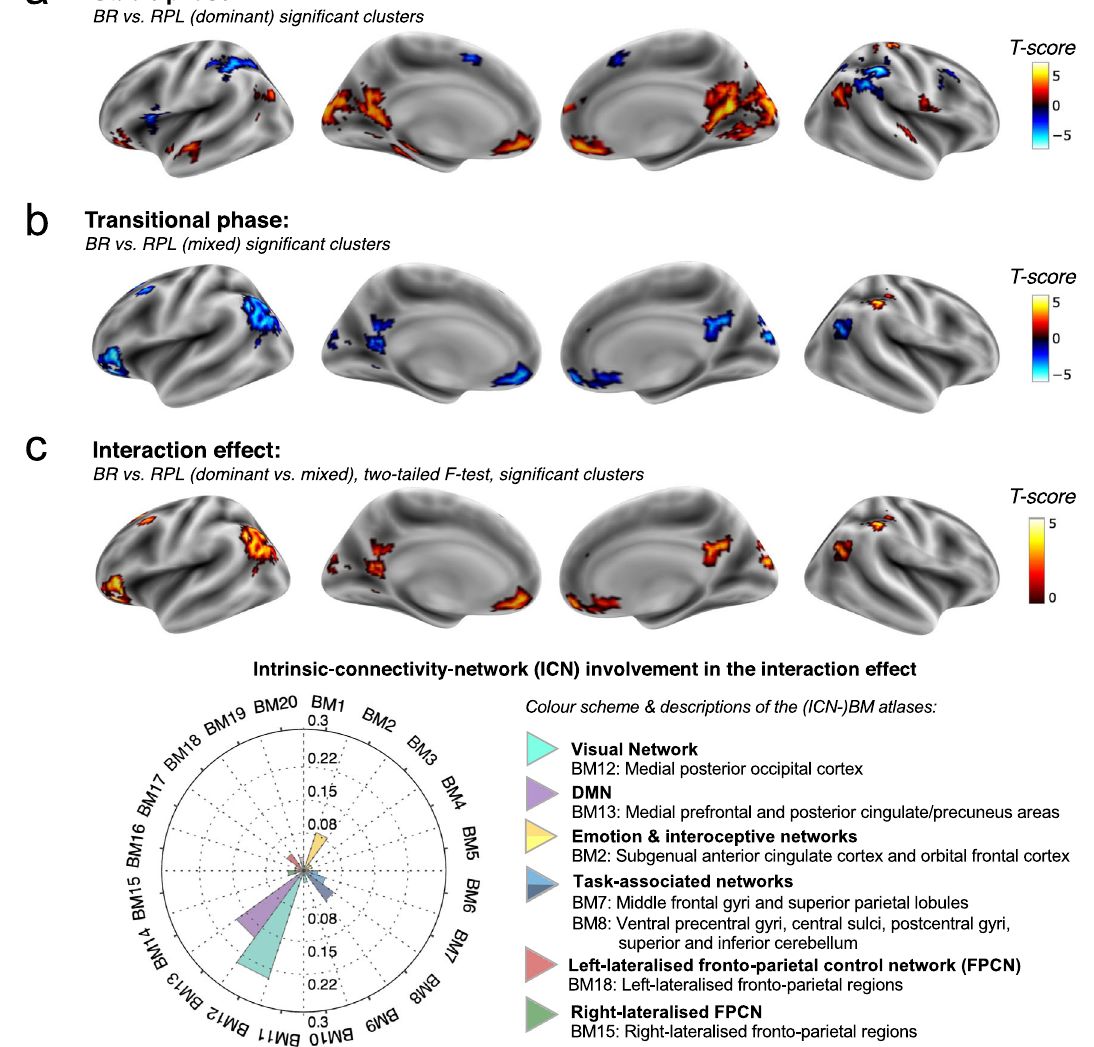
Fig. 2 | FMRI activation revealing the DMN ’ s involvement in the current